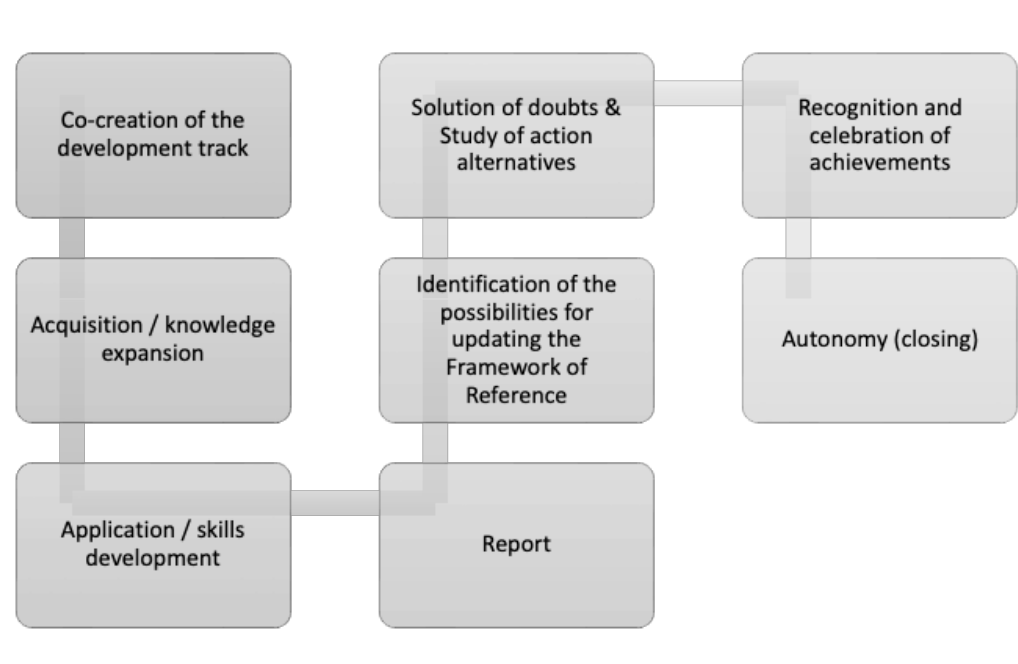
Figure 1: Development Hive